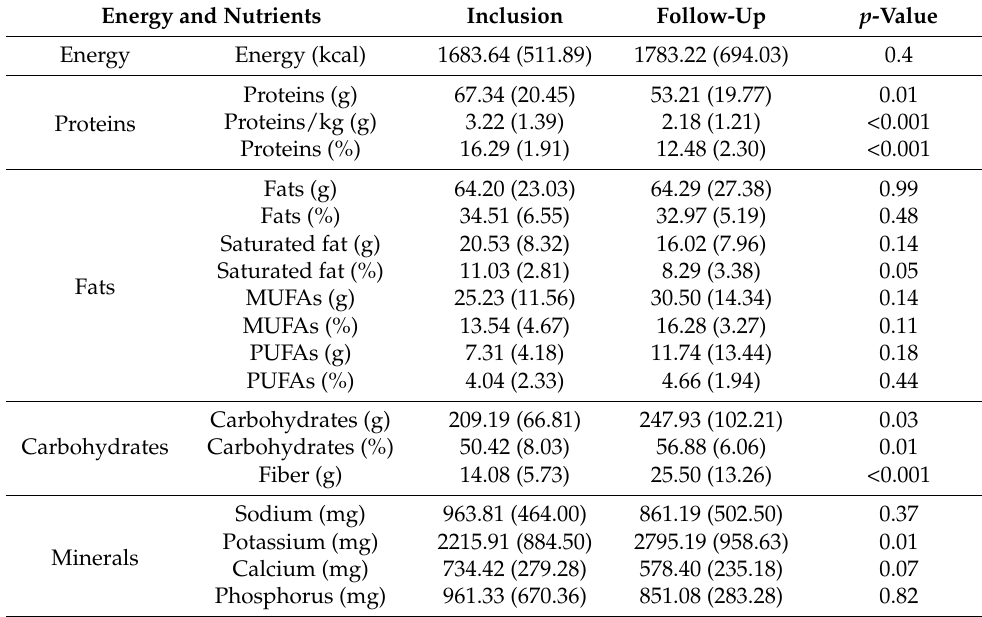
Table 3. Daily energy and nutrients consumption at baseline and last follow-up after nutrition intervention.